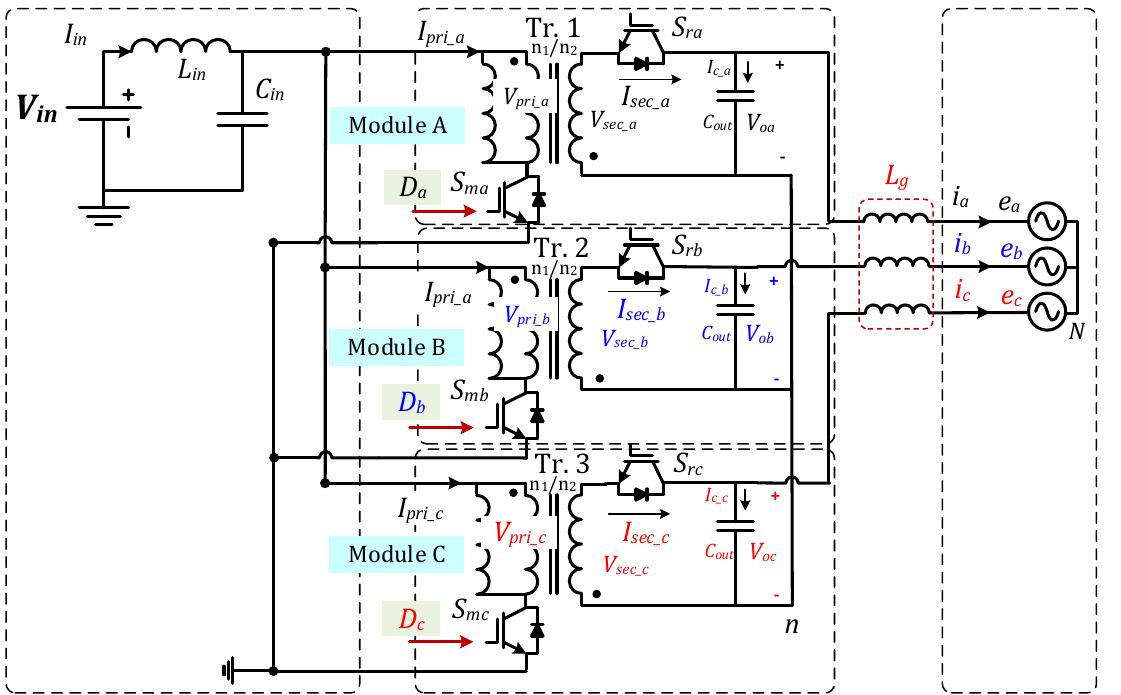
Figure 1. Three-phase single-stage isolated flyback inverter.